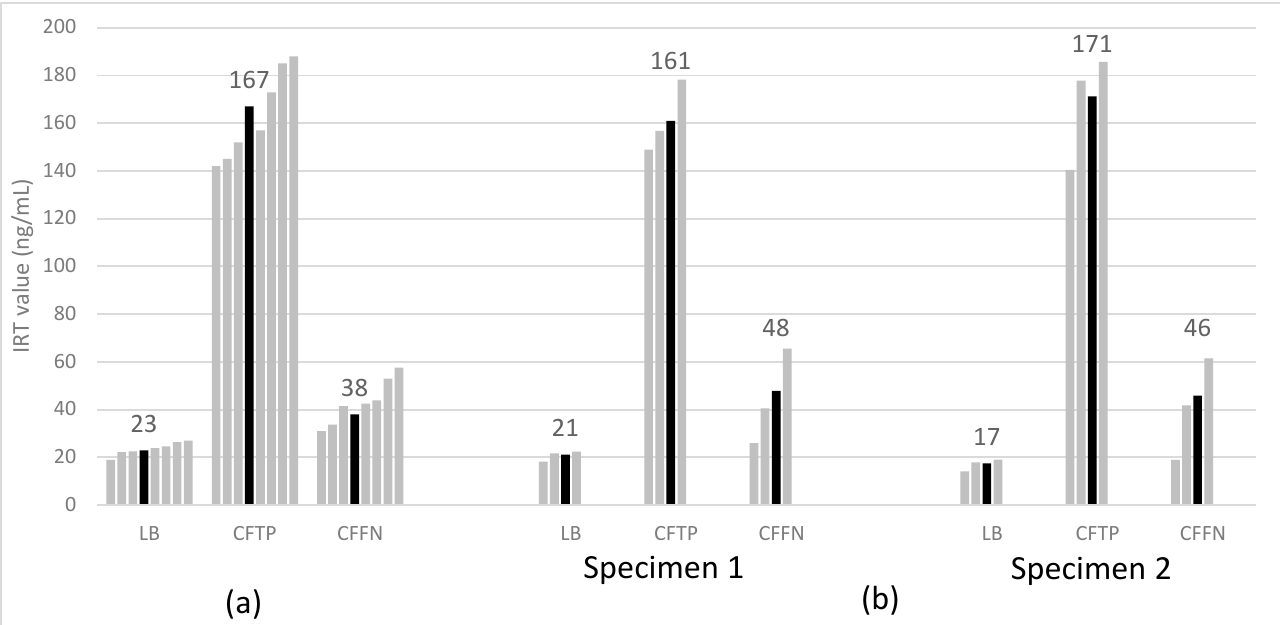
Figure 1. State median (gray bars) and weighted average median (black bars) IRT value for study groups in 7 one-specimen ( a ) and 3 two-specimen ( b ) states. CFFN, false screen negative CF cases due to IRT below program cutoffs; CFTP, true screen positive CF infants; IRT, immunoreactive trypsinogen; LB, all screened newborns.